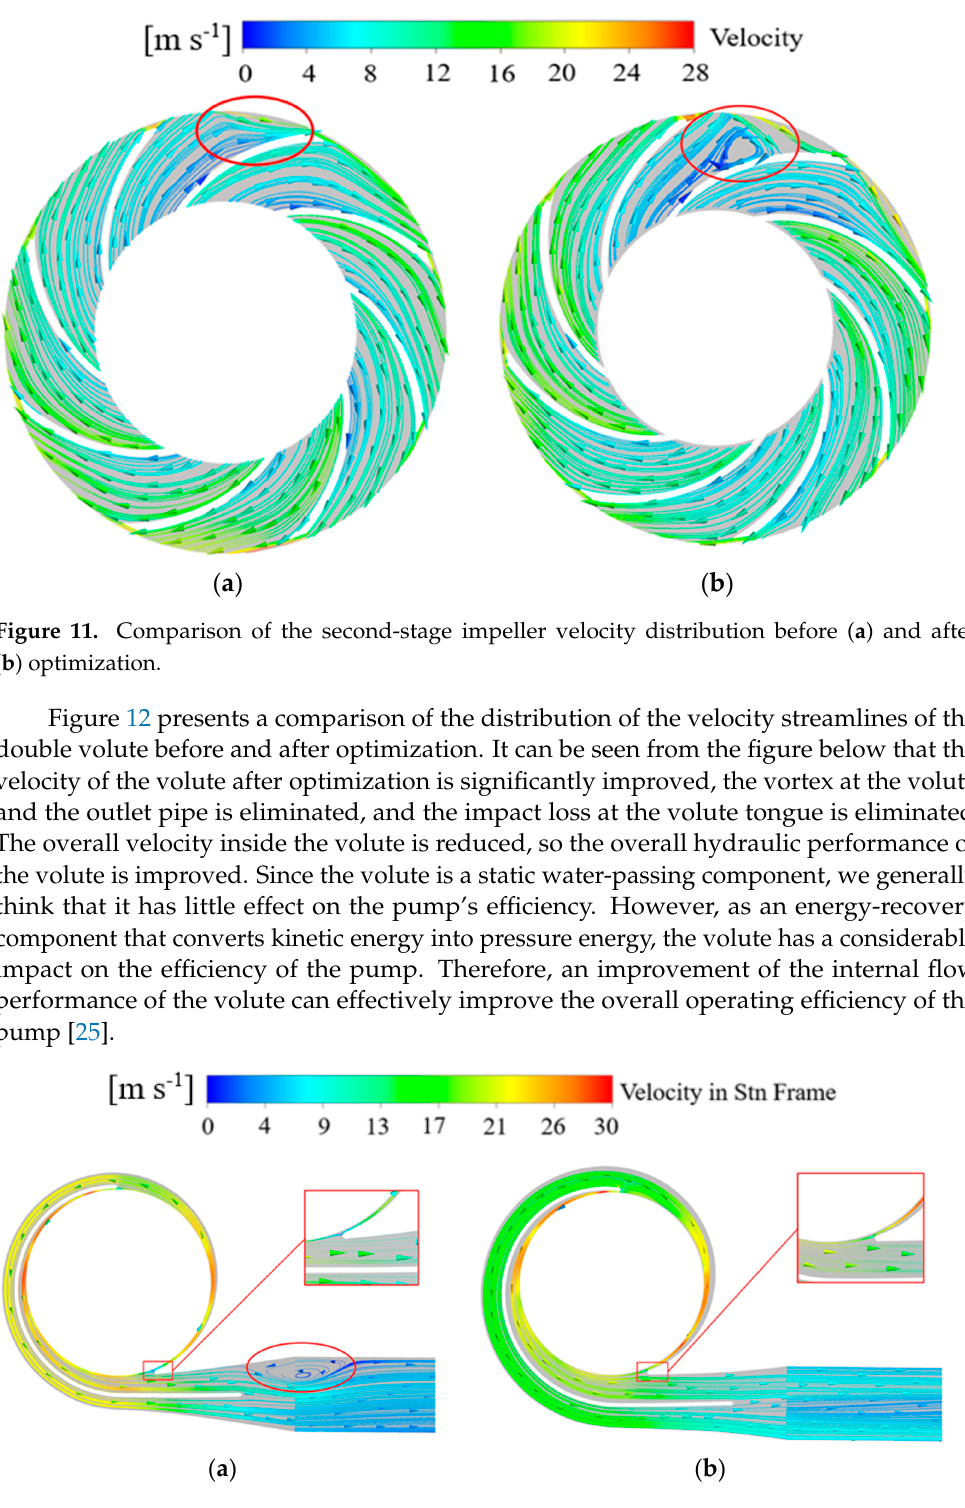
Figure 12. Comparison of the velocity streamline distribution of the double volute before ( a ) and after ( b ) optimization.